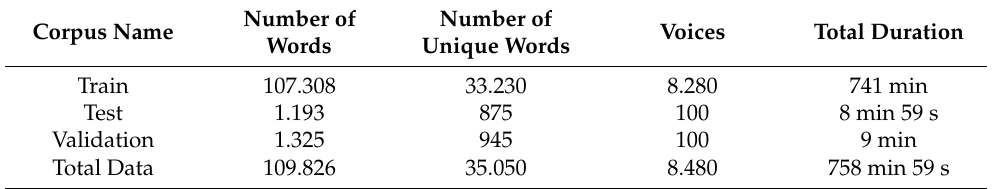
Table 3. Corpus distribution.